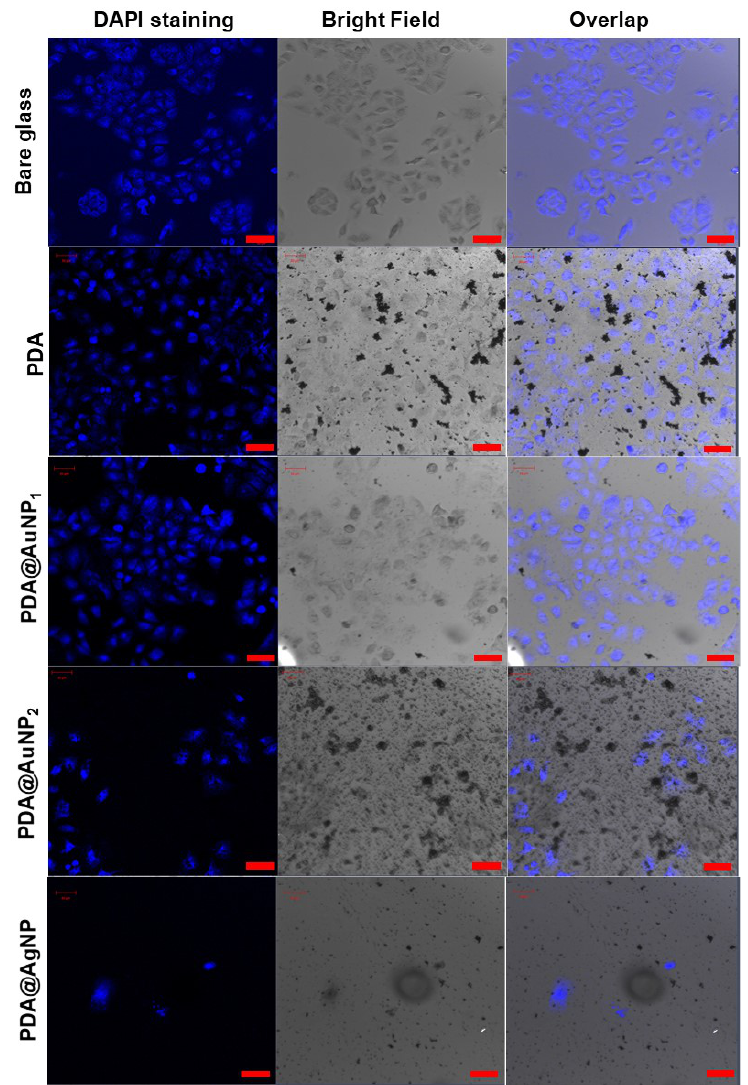
Figure 3. Confocal microscope images of A549 cells on different surfaces at 20× magnification. Scale bars are 50 µm.